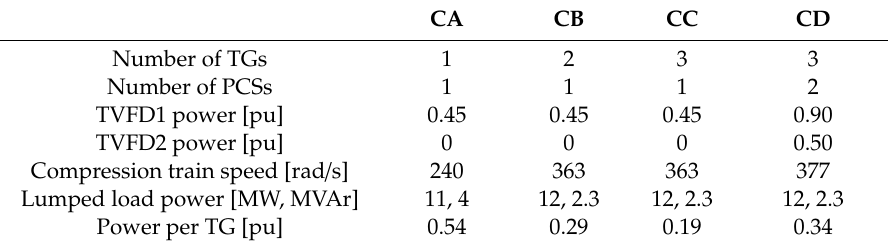
Table 9. Experimental configurations of the LNG